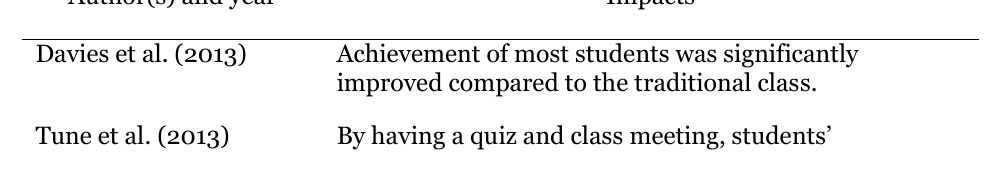
Students’ Achievement